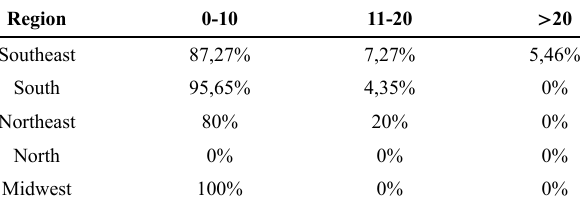
Table 6 - Book chapters published between 2015 and 2019 by